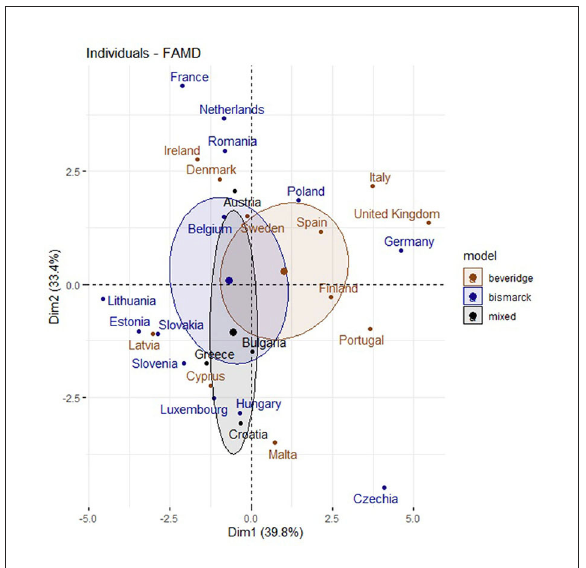
FIGURE13 Distribution of the countries and dimensión 1 and dimensión